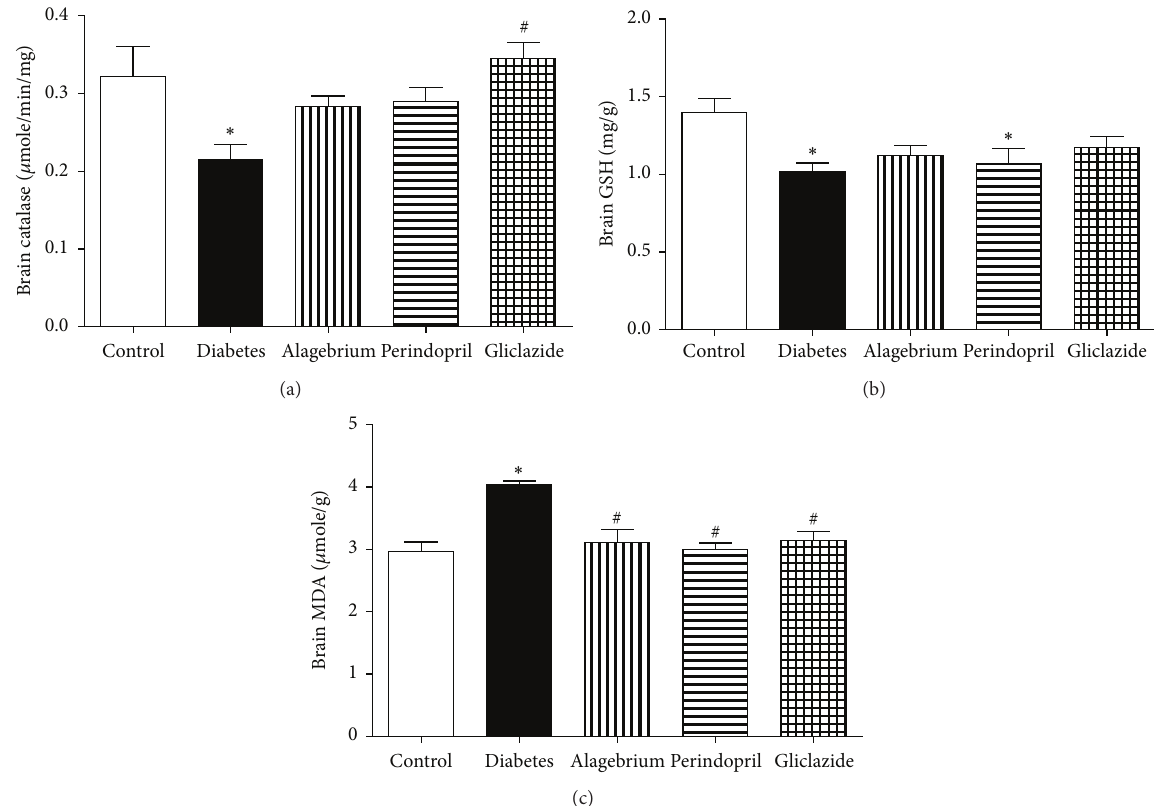
Figure 4: Effects of alagebrium (10mg/kg), perindopril (4mg/kg), or gliclazide (10mg/kg) on (a) brain catalase activity, (b) brain GSH content, and (c) brain MDA content in STZ-induced diabetes in rats. Data are presented as mean ± SEM ( 𝑛 = 6 ). ∗ Significantly different from control group. # Significantly different from diabetic group at 𝑃 < 0.05 using ANOVA followed by Tukey’s post hoc